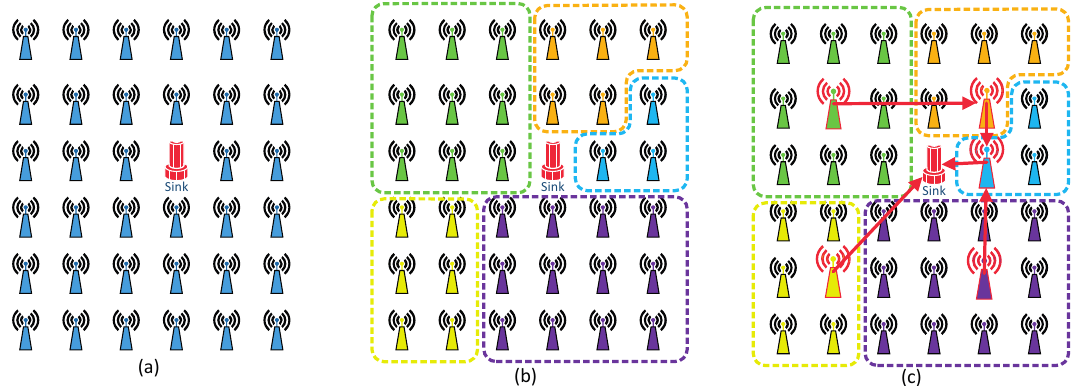
Figure 1. An overview of GTRF. ( a ) Nodes are uniformly distributed; ( b ) Clustering protocol is applied, which groups all nodes into five clusters; ( c ) Each cluster designate a cluster head for data collecting, aggregating and